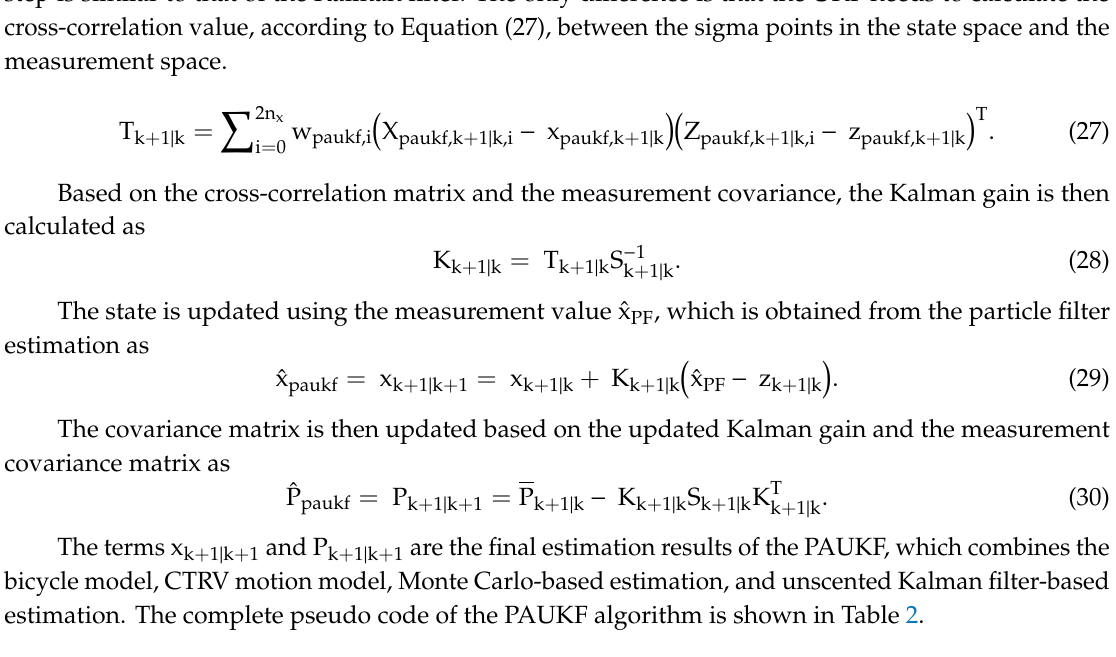
Table 2. Pseudocode of the particle-aided unscented Kalman filter